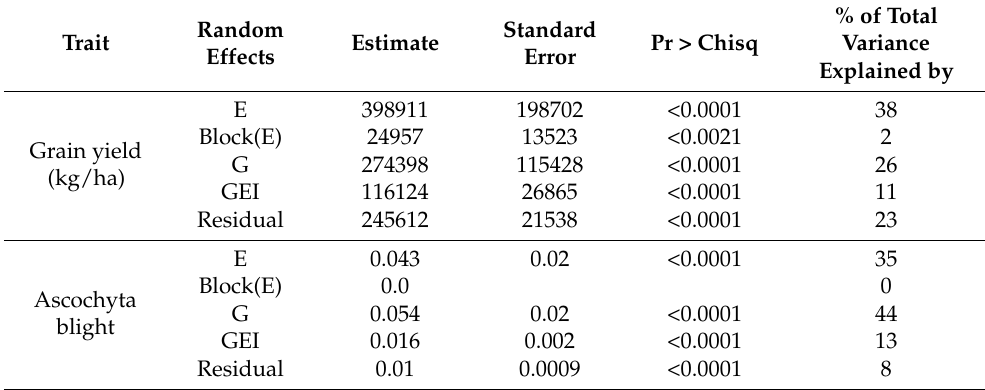
Table 3. Pooled analysis of variance and estimated variance components of grain yield (kg/ha) and ascochyta blight (transformed data) of a chickpea performance trial, consisting of 14 genotypes (G) grown in 10 environments